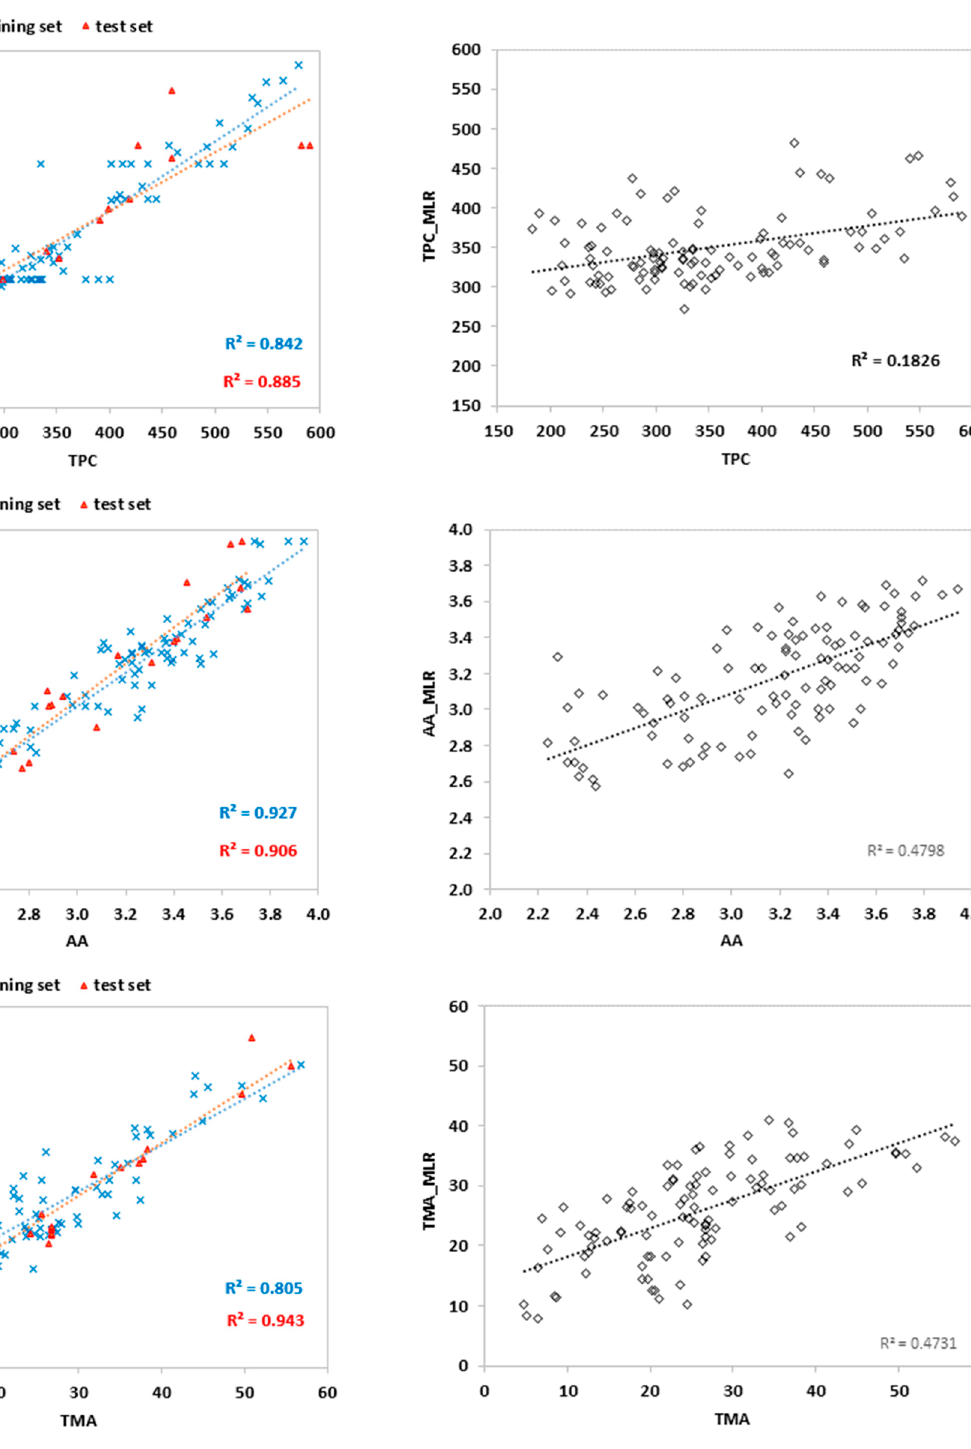
Figure 7. Predicted vs. experimental values of the flesh firmness (FF), total soluble solid content (TSS), titratable acidity (TA), total phenolic content (TPC), antioxidant activity (AA), and total monomeric anthocyanin (TMA) using the optimal ANN topologies and multiple linear regression (MLR). The coefficients of determination (R 2 ) are reported.